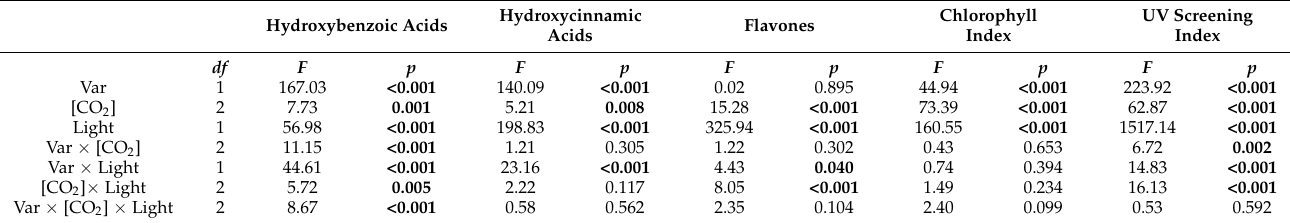
Table 2. Results of three-way ANOVA on the effects of barley ( Hordeum vulgare) variety (Var), CO 2 concentration ([CO 2 ]), light intensity (Light), and their mutual interactions on total hydroxybenzoic acids, hydroxycinnamic acids, and flavones determined by HPLC-HRMS and on chlorophyll and UV screening index measured in vivo using the instrument Dualex. Degrees of freedom ( df ), F and p values are denoted for each factor or interaction. Significant effects ( p < 0.05) are indicated in